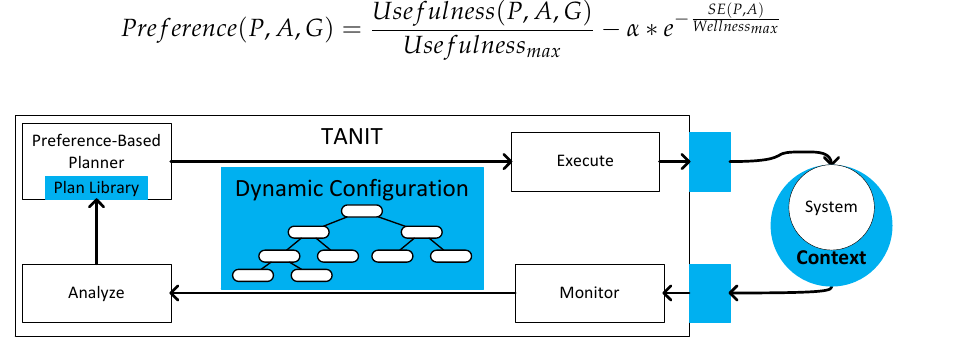
Figure 3. Overall picture of the DSPL